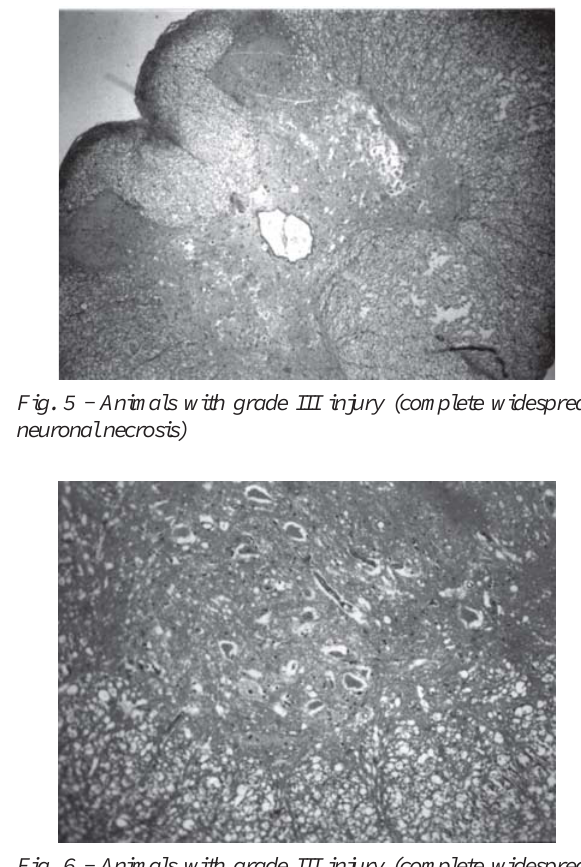
Fig. 3 - Sections from spinal cords of animals in the sham operations